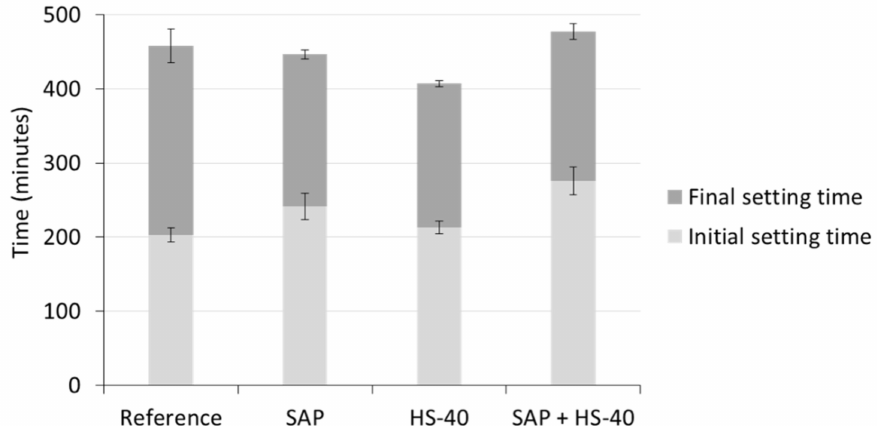
Figure 5. Ultrasound velocity versus time of mortar mixtures.